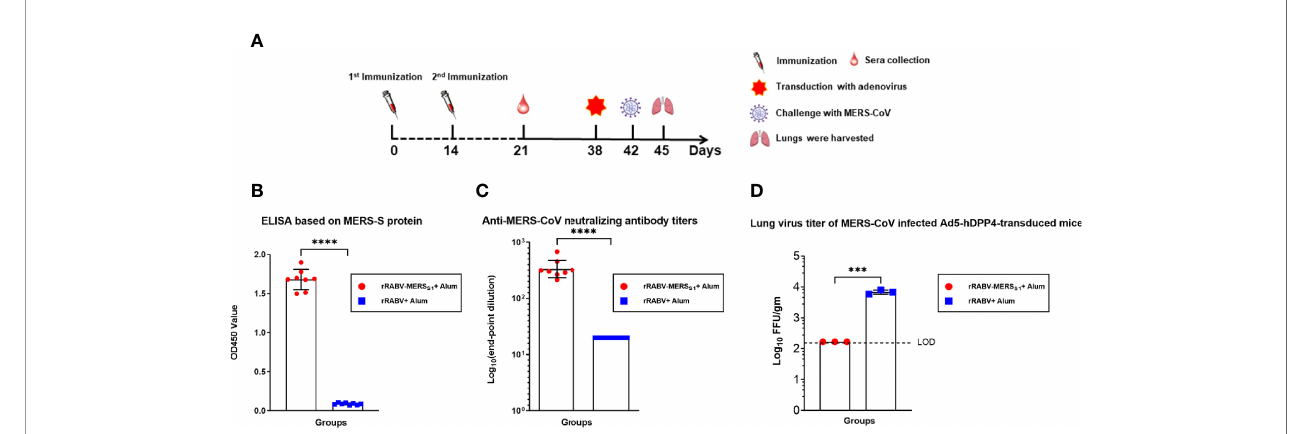
FIGURE 4 | Immunization with the rabies virus-vectored MERS-CoV vaccine provides protection in MERS-CoV-infected Ad5-hDPP4-transduced mice model. (A) The schematic of the live challenge experiment. Six- to eight-week-old speci fi c pathogen-free female C57BL/6 mice (n = 8 per group) were intramuscularly (i.m.) injected with either the inactivated recombinant rabies virus MERS-CoV vaccine or inactivated parental rabies virus vaccine on days 0 and 14; sera from each group of mice (n = 8) were collected on day 21. All mice were transduced with Ad5-hDPP4 5 days as previously described before intranasal challenge with 1 × 10 5 PFU MERS-CoV (EMC/2012 strain) on day 42, and then the lungs from each group of mice (n = 3) were harvested for virus titration. (B) Binding and (C) neutralizing activities of sera collected on day 21 were respectively measured by indirect ELISA and live MERS-CoV (EMC/2012 strain). (D) On day 3 post-infection, virus titers in the lungs were measured on Vero 81 cells and expressed as FFU/g tissue. Data are shown as mean ± SD. Data were obtained using GraphPad Prism version 9.0 (GraphPad software). An unpaired Student ’ s t-test (two-tailed) was used for statistical analysis, and the relevant p-values are indicated (not indicated in graph; ***p < 0.001, ****p <